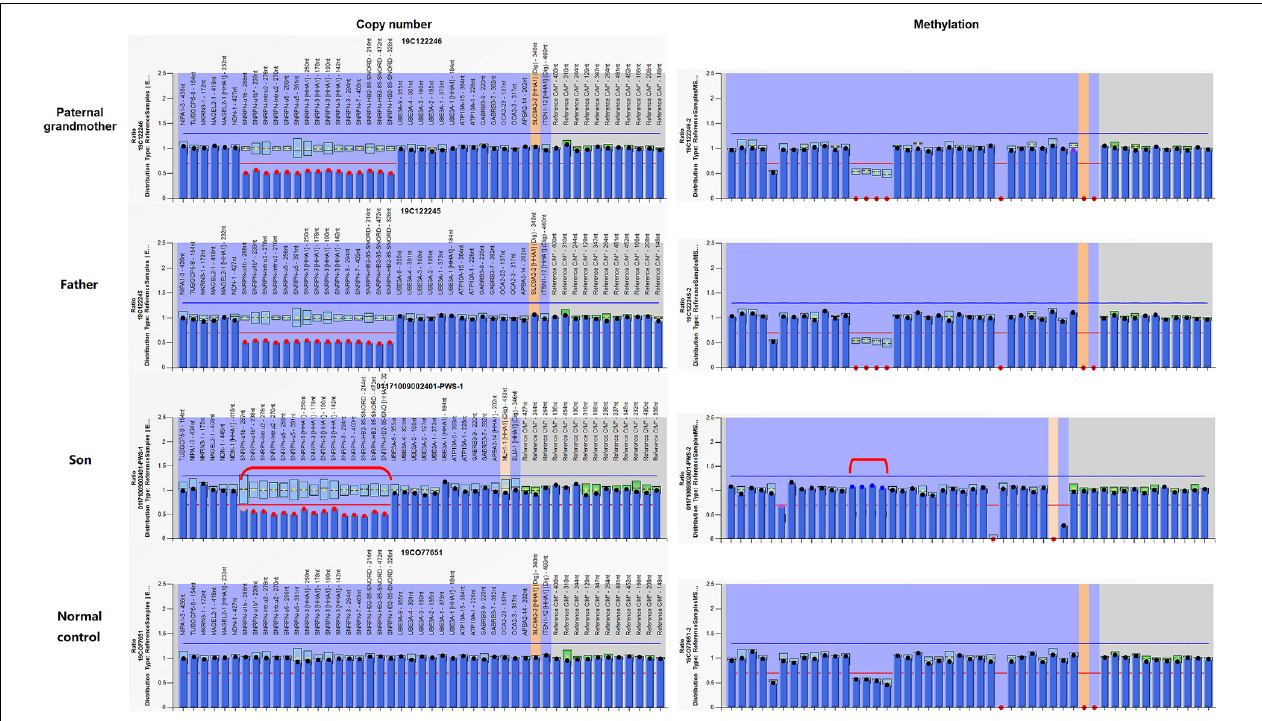
FIGURE 3 | Copy number and methylation patterns generated using Methylation-Specific Multiplex Ligation-dependent Probe Amplification B2 kit (MS-MLPA-B2). The Prader–Willi syndrome/Angelman syndrome (PWS/AS) kit contains 48 probes for copy number detection and methylation status analysis that are specific to regions in or near the PWS/AS critical region on chromosome 15q11-q13. The left and right columns display the results of copy number and methylation pattern, respectively. In the left column, copy number peak ratios are determined by comparing patient with normal control (2 copies/2 copies = 1.0). The figure reveals deletion (showing a copy number of 1) in 15 probes in and around the SNRPN region (highlighted in red dots) in the paternal grandmother, the father, and the patient. Meanwhile, the normal control has a normal copy number of 2 for all analyzed gene fragments of chromosome 15. The methylation probes were designed to hybridize to maternally imprinted loci, shown in the right column. When compared to the normal control, each of the four probes within the deleted region has a ratio of around 0.5. In this family, the paternal grandmother and the father display an abnormal methylation pattern (ratio = 0) in the SNRPN region due to complete loss on the maternal chromosome 15, while the patient displays the typical PWS methylation pattern (ratio = 1) in the four SNRPN probes due to complete loss on his paternal chromosome 15. UBE3A exon 1 and one other digestion control probe were used during the methylation analysis. These results indicate that in the paternal grandmother and the father, the paternal allele is present, and the deletion is maternal in origin, which explains their absence of clinical symptoms. In contrast, the child displays an abnormal methylation pattern in the four methylation-sensitive fragments digested in the SNRPN region due to loss on his paternal chromosome